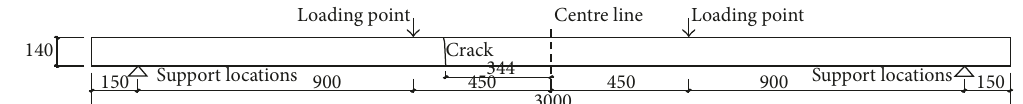
Figure 28: Failure mode of CB-1.